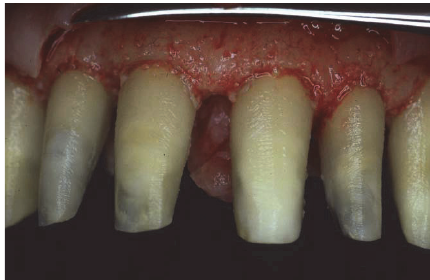
Figure 14: Once the initial healing was completed, 3 months later, the temporaries were relined.